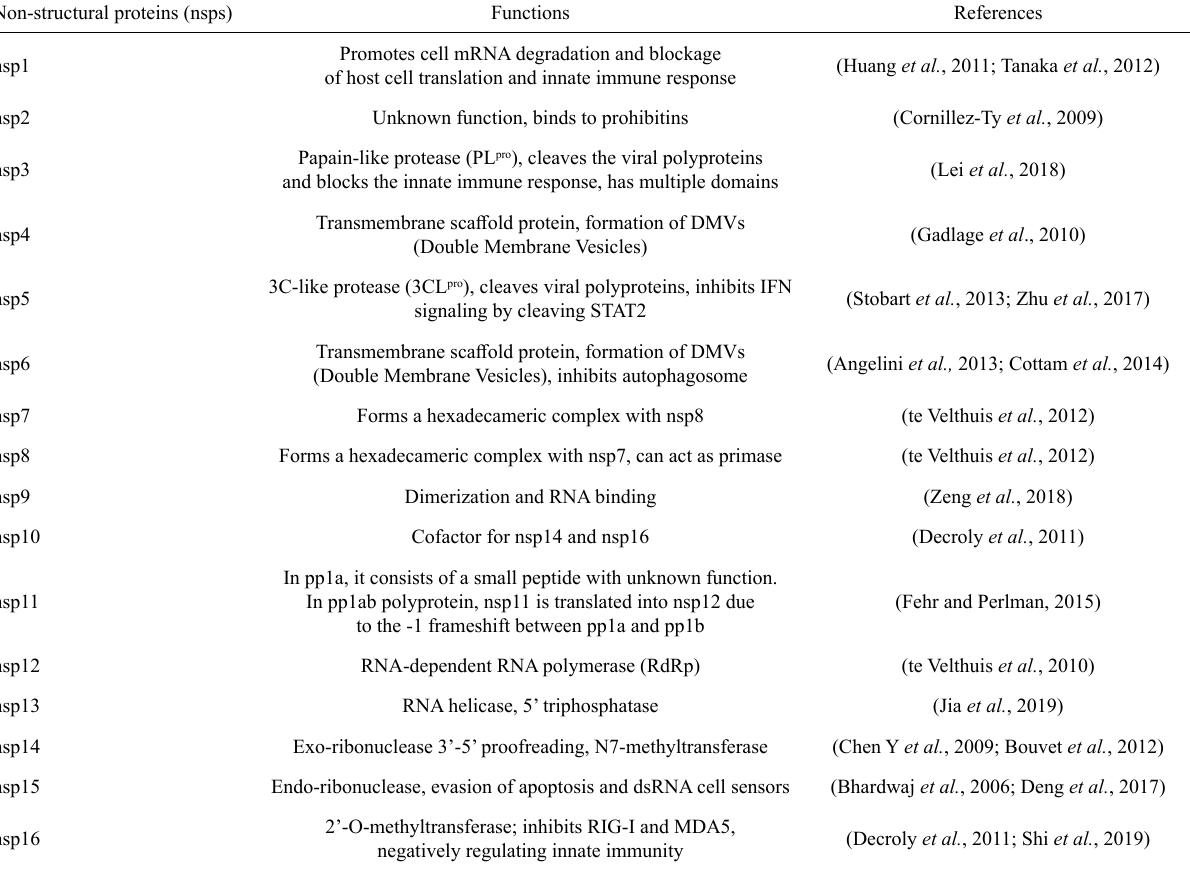
Table 1 – Non-structural proteins of coronaviruses and their functions. Non-structural proteins